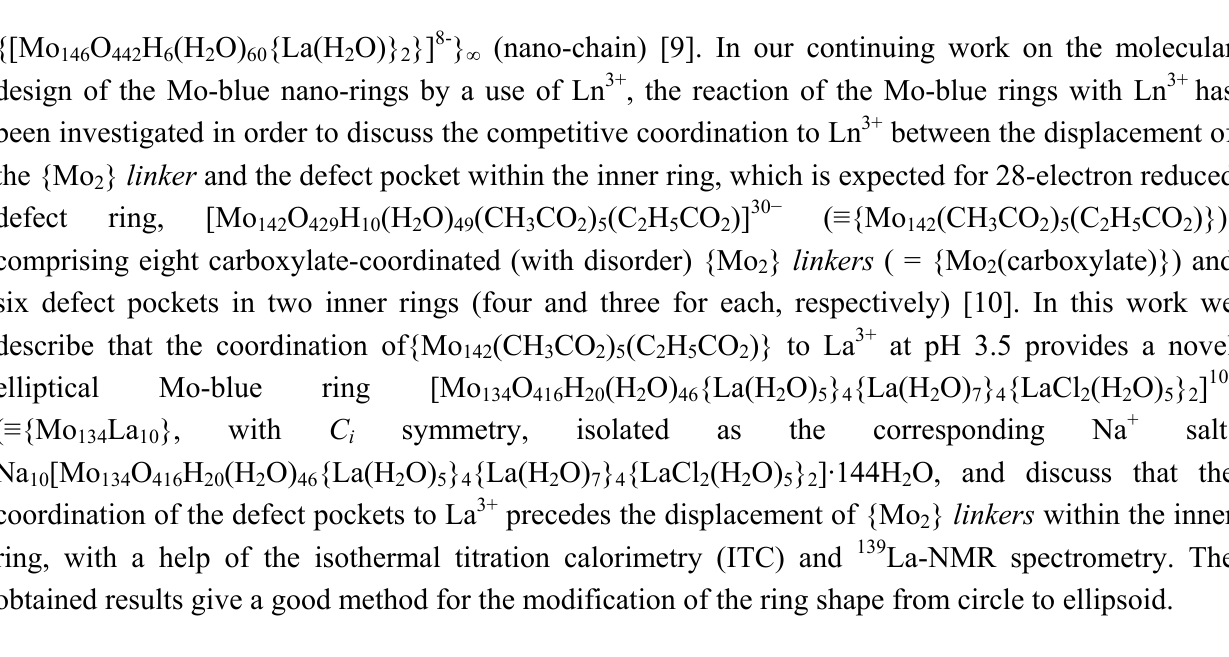
La } (a) and the Eu- 150 2